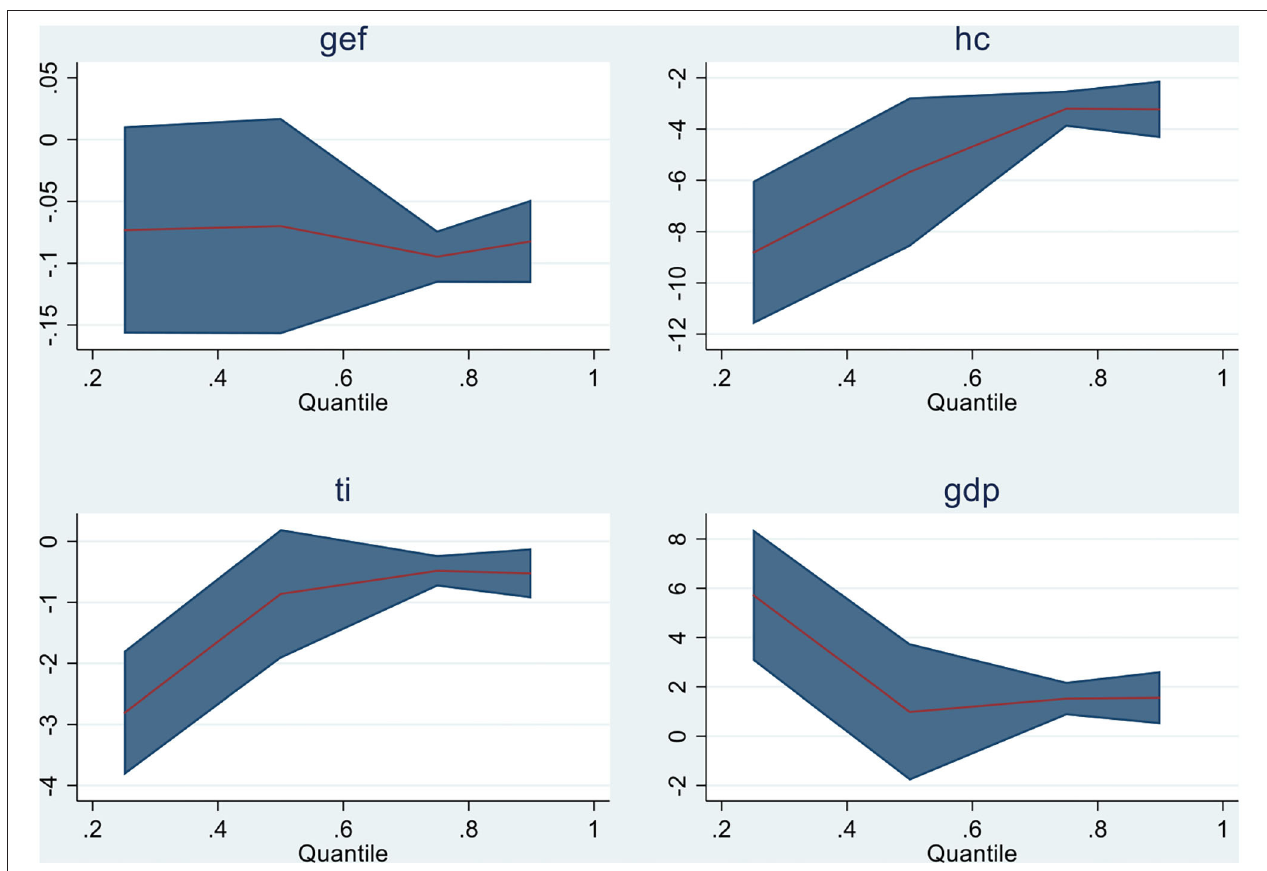
FIGURE 3 | Graphical representation of quantiles for Model